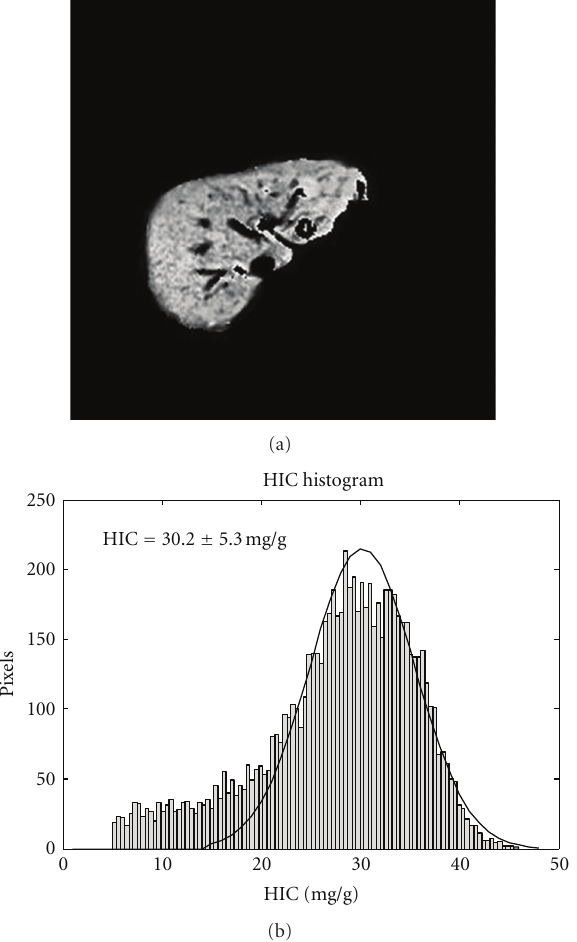
Figure 3: A 31-year-old man with acute myelogenous leukemia, sixteen months after bone marrow transplantation. (a) is the HIC map of the segmented liver. (b) is its corresponding histogram with normal distribution fit. This patient had very high iron deposition with mean HIC value of 30.20 mg/g ( T ∗ 2 < 1 . 0msec). Figure 4: An example of T ∗